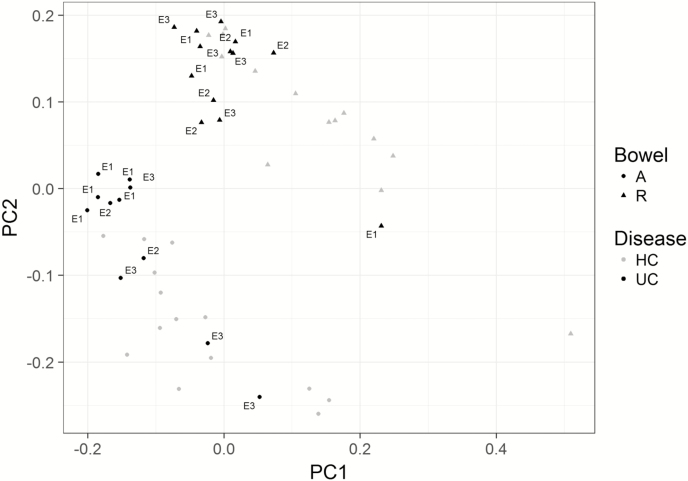
PCA of microarray transcriptome data from bowel biopsies: The biopsies are distinguished by location (ascending colon [circle] or rectum [triangle]), disease status (UC [black] or HC [gray]), and Montreal classification of the UC (E1, proctitis; E2, left-sided colitis; E3, pancolitis).